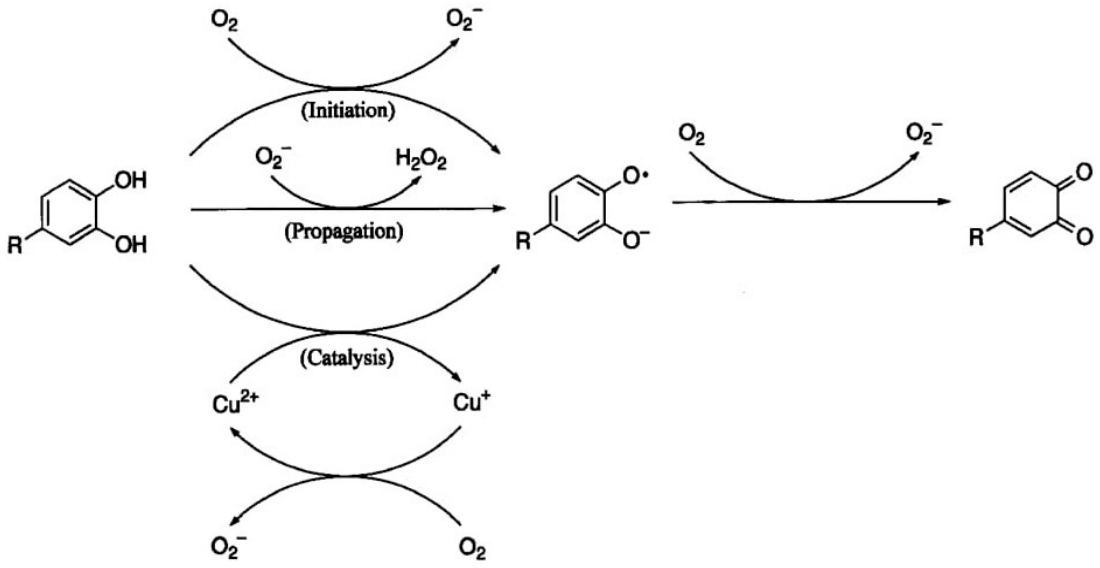
Figure 4. Production of hydrogen peroxide (H 2 O 2 ) by polyphenols via autoxidation (Source: Akagawa et al. [62]). (c)